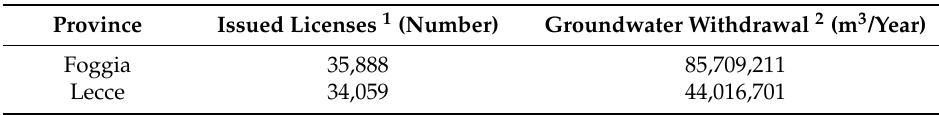
Table 2. Irrigation groundwater estimates in Apulia Region.